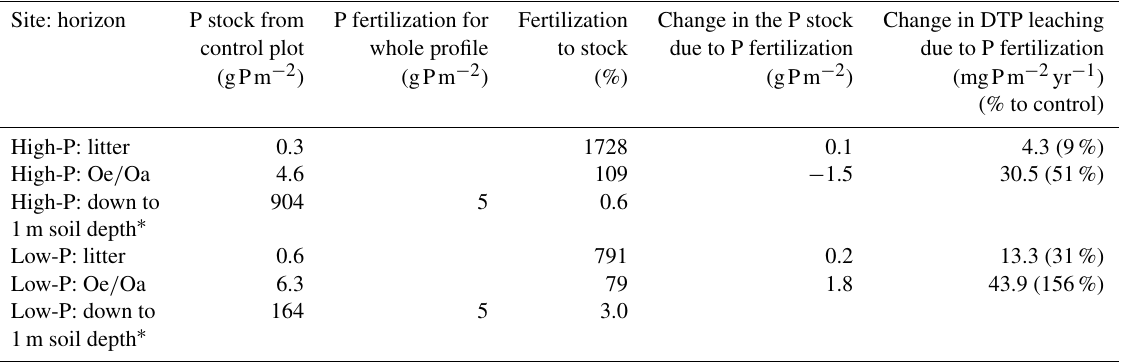
Table 5. Soil phosphorus (P) stocks from the control plots ( n = 3) at the high-P and the low-P site for the litter and the Oe / Oa horizon, as well as added amounts of P, and the change in annual leaching of dissolved total P (DTP) and in element stocks due to fertilization. Other treatments are given in Sect. S10 in the Supplement.